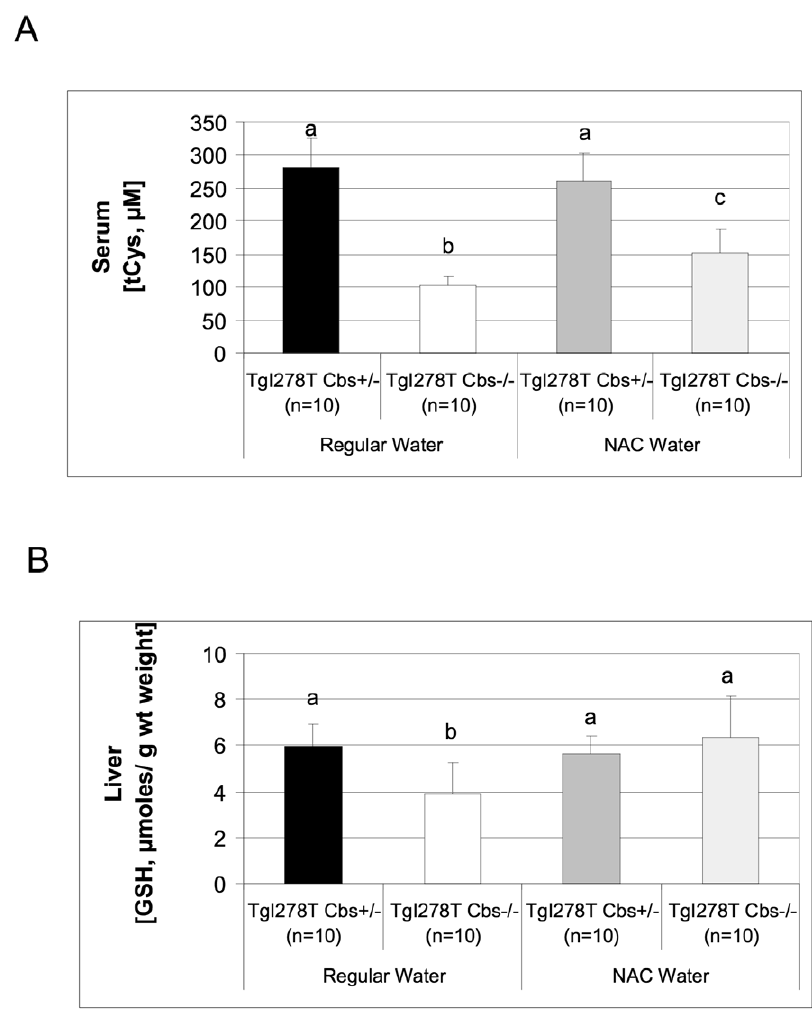
Figure 4. Effect of CBS genotype and NAC treatment on serum total cysteine and liver GSH. ( A ) Serum tCys. ( B ) Liver GSH. All four groups include 5 male and 5 female animals that were measured at 240 days of age. Graphs show the mean 6 SD. Having different letters at the top of the error bar indicates significant differences between columns.